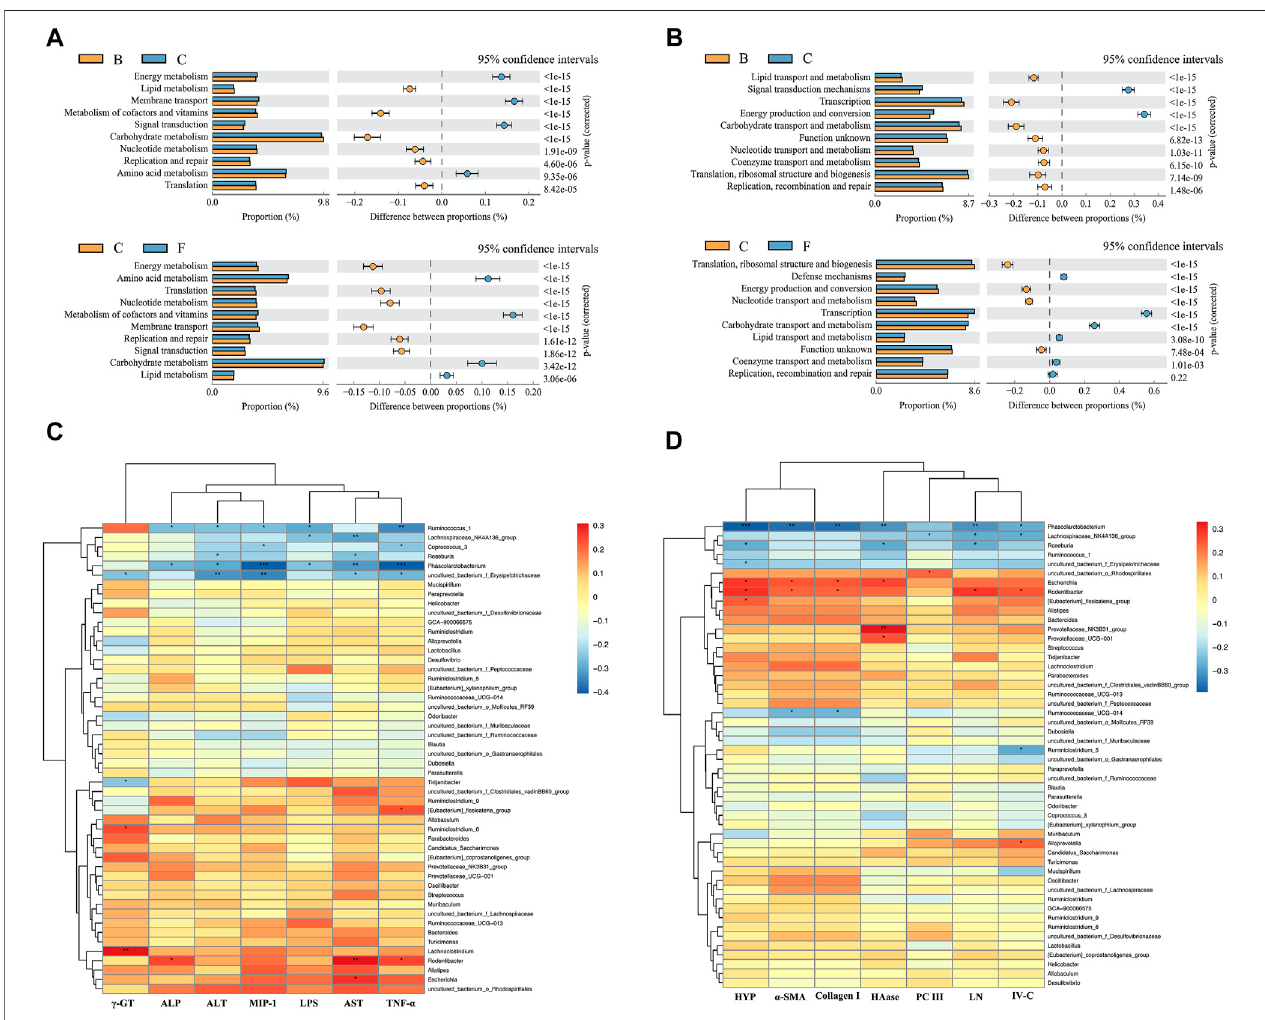
FIGURE9| Function prediction analysisofgutmicrobiotaand Correlation analysisheatmap. (A) Predictionofmicrobiomefunctionbased onKEGGdatabase. (B) Prediction of microbiome function based on COG database. (C) Correlation analysis of intestinal micro fl ora and serum biochemical indexes in mice. (D) Correlation analysis of intestinal micro fl ora and liver biochemical indexes in mice. B: Solvent control; C: CCl 4 ; F: CCl 4 + 40 mg/ kg PHI.